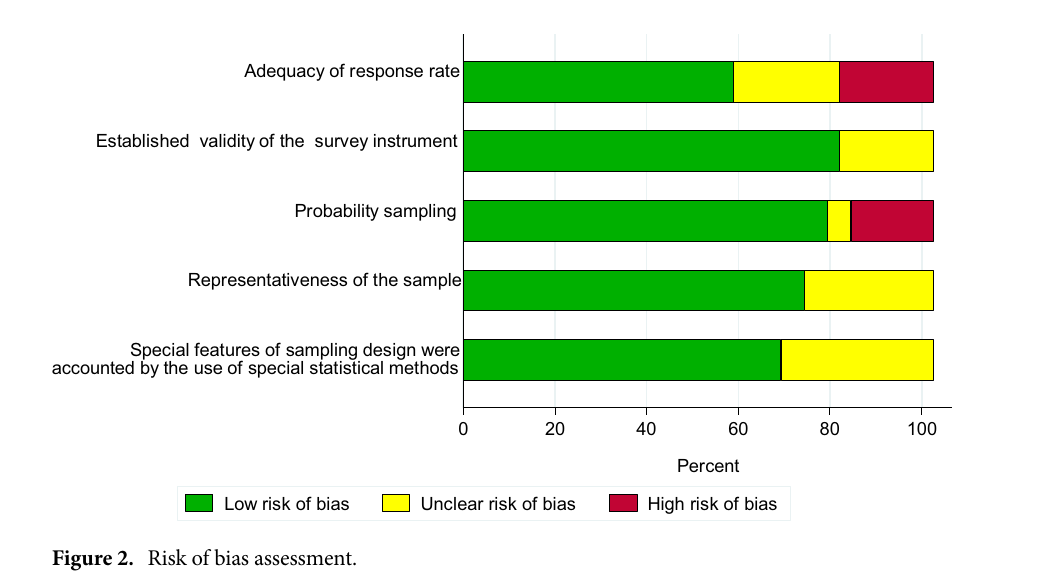
Figure 2. Risk of bias